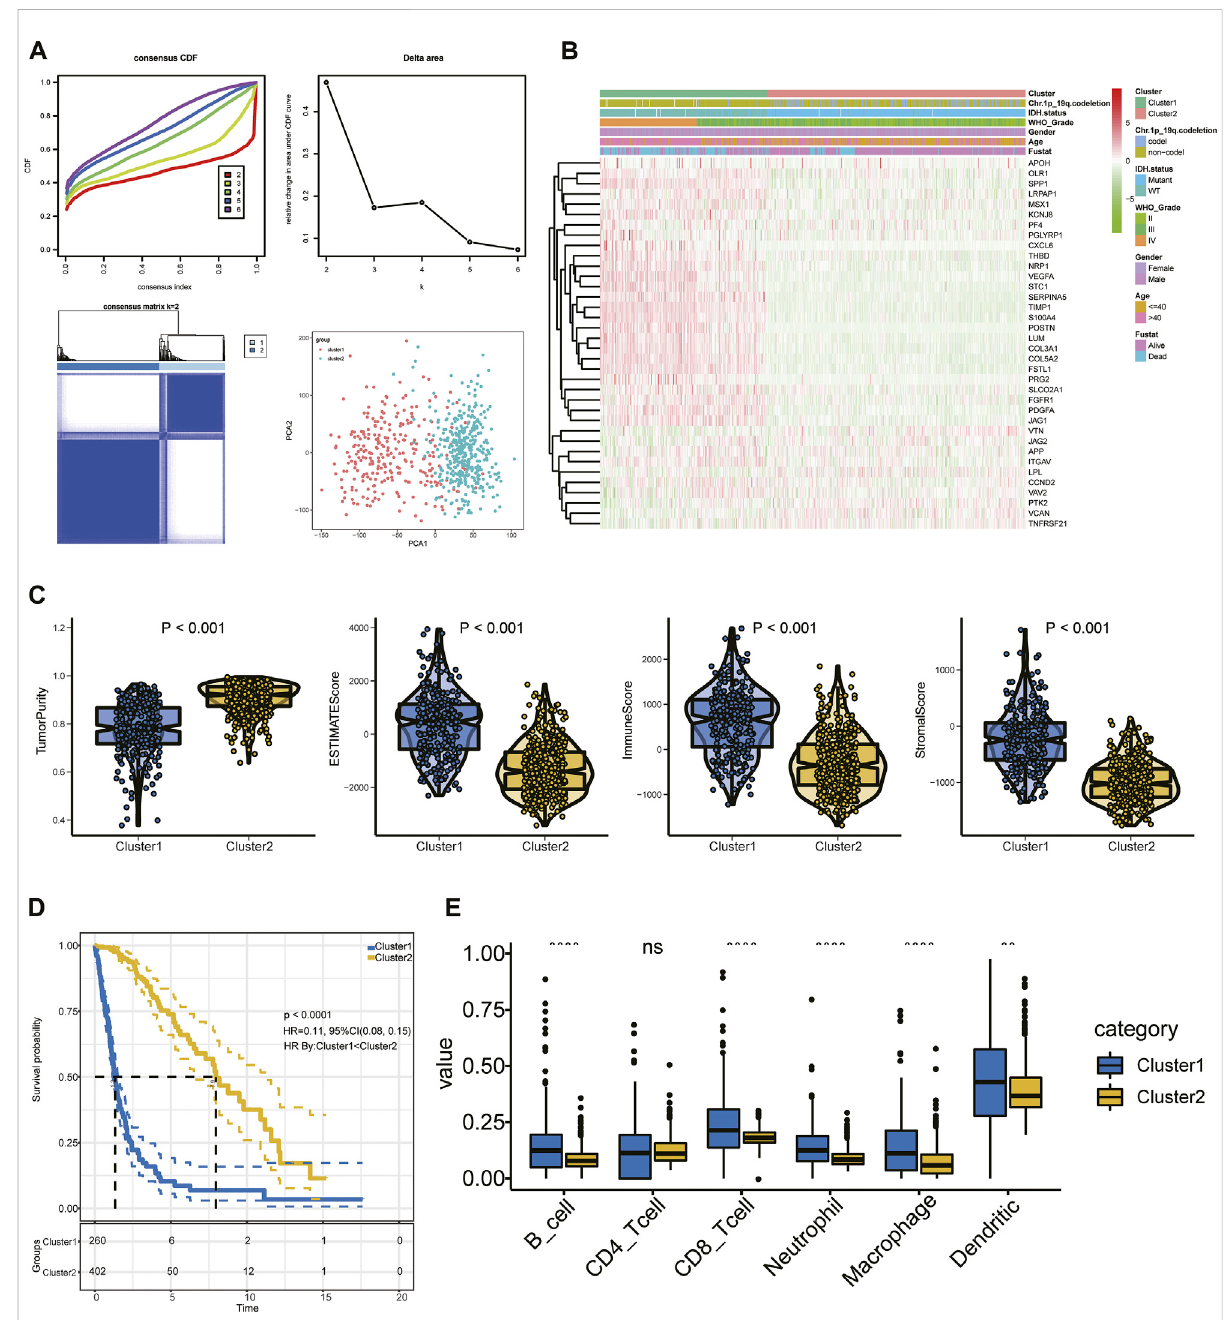
FIGURE 2 (A) Consensusclustering, CDF, andrelativechangeintheCDFAUCwith k =2 – 6. (B) Heatmapofclinicalinformation